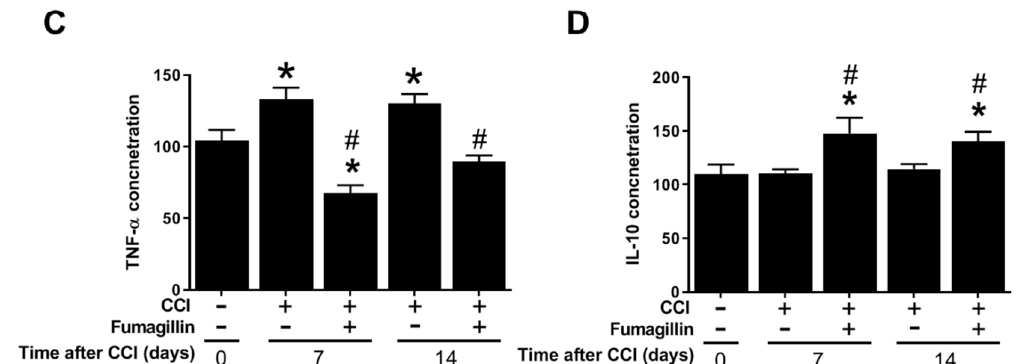
Figure 7. Effects of intrathecal administration of fumagillin on cytokine levels in the spinal cord of CCI rats 7 and 14 days following CCI. ( A ) interleukin − 1 β (IL − 1 β ), ( B ) tumor necrosis factor − α (TNF − α ), ( C ) IL − 6, and ( D ) IL − 10 levels in the spinal cord of control rats ( n = 8) and chronic constriction injury (CCI) rats at post − operative day (POD) 7 ( n = 8), CCI + fumagillin rats at POD 7 ( n = 6), CCI rats at POD 14 ( n = 6), and CCI + fumagillin rats at POD 14 ( n = 8). Data are represented as means ± standard error of means (SEMs), * p < 0.05 compared with the control group; # p < 0.05 compared with the CCI group at POD 7; one-way analysis of variance (ANOVA) with post hoc Tukey test. The “ − ” sign means the absence and “+” sign means presence of various treatment with either CCI or fumagillin in the rats..